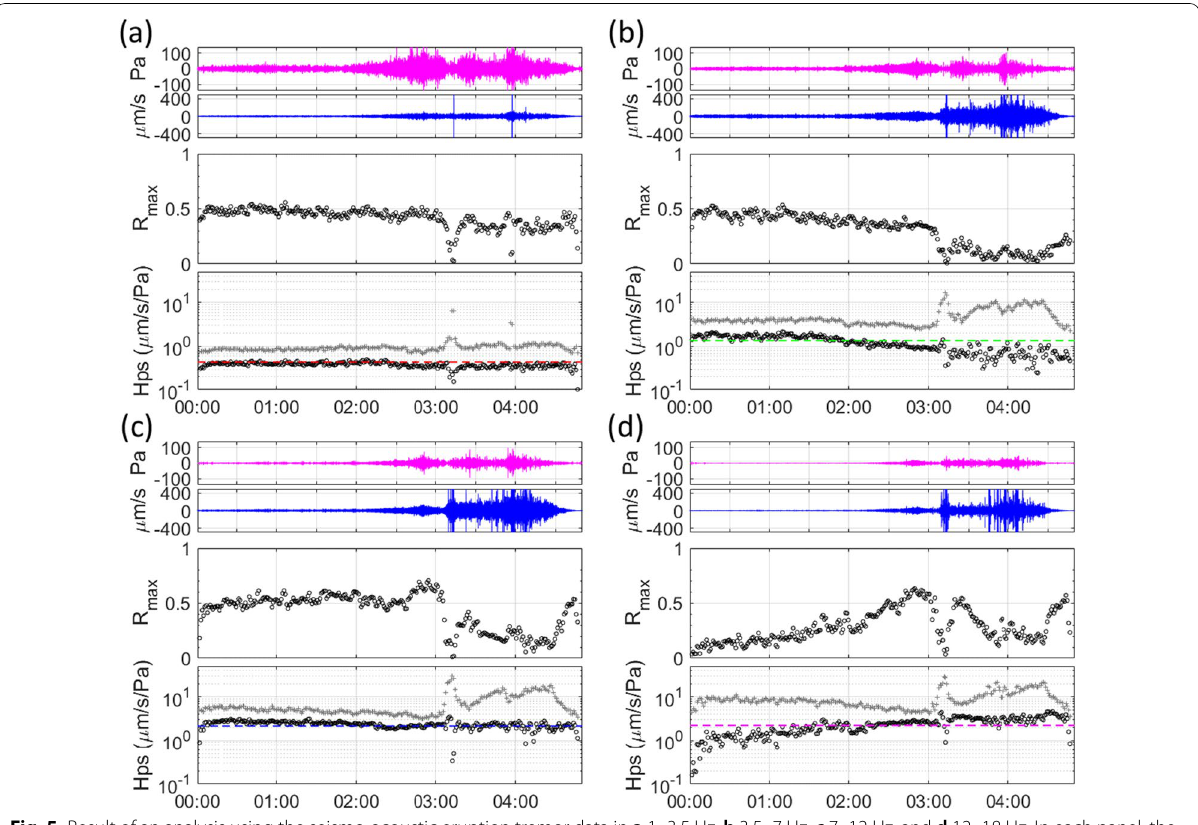
Fig. 5 Result of an analysis using the seismo-acoustic eruption tremor data in a 1–3.5 Hz, b 3.5–7 Hz, c 7–12 Hz, and d 12–18 Hz. In each panel, the top two frames show the acoustic and seismic data in the frequency band ( d p and d v , respectively), and the third shows the maximum correlation between d p and d h v . In the bottom frame, the open circles show the calculated H ps using this data in a 120-s time window moving every 60 s, the colored dashed line indicates the reference value from Fig. 3, and the crosses